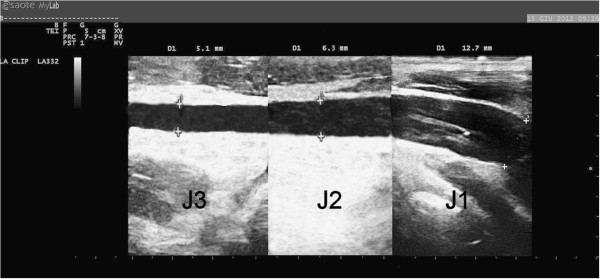
A normal IJV. Progressive reduction of the vessel diameter proceeding from J1 point (12.7 mm) to J3 (5.1 mm) and passing through J2 (6.3 mm).